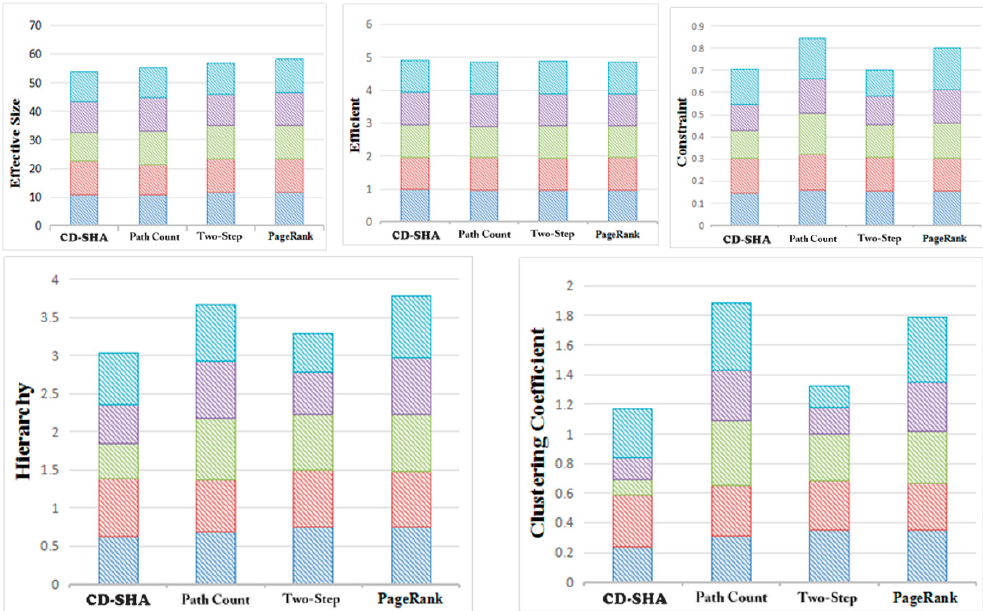
Figure 6. The performance of the CD-SHA algorithm, the Path Count algorithm, the two-step connectivity algorithm and the PageRank algorithm regarding the effective size, the efficiency, the constraint, the hierarchy, and the clustering coefficient in the football network. Appl. Sci. 2020 , 10 , 4525 11 of 12